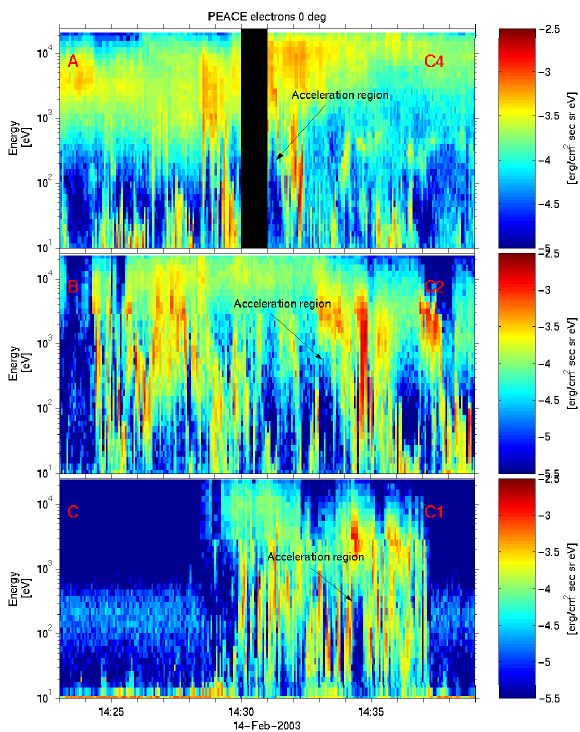
Fig. 2. Energy spectra of downgoing electrons from Cluster space- craft 4 (panel (A) ), 2 (B) and 1 (C) . An acceleration region observed by all spacecraft is